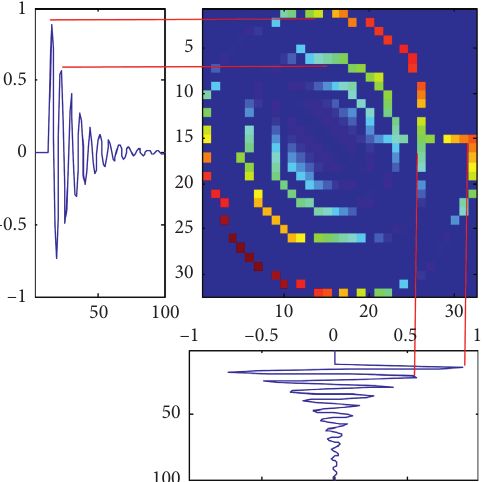
Figure 5: The correspondence between the fault response frag- ments and the mesh phase